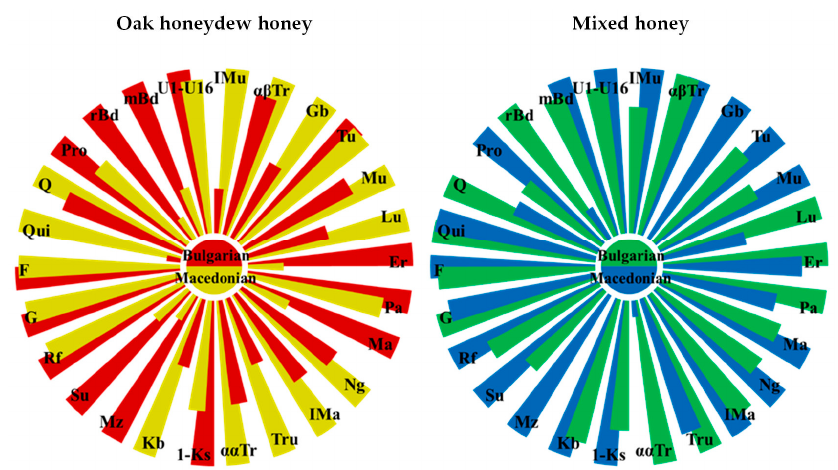
Figure 2. Nightingale’s Rose Diagrams of the content of 26 constituents in Bulgarian and North